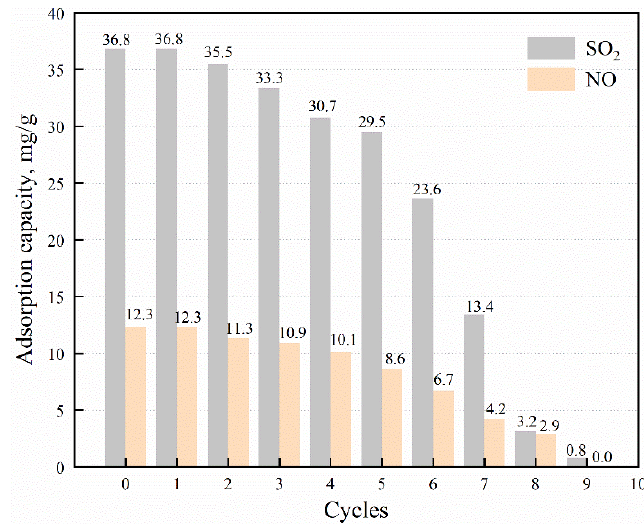
Figure 11. Adsorption-desorption cycles of adsorbent.